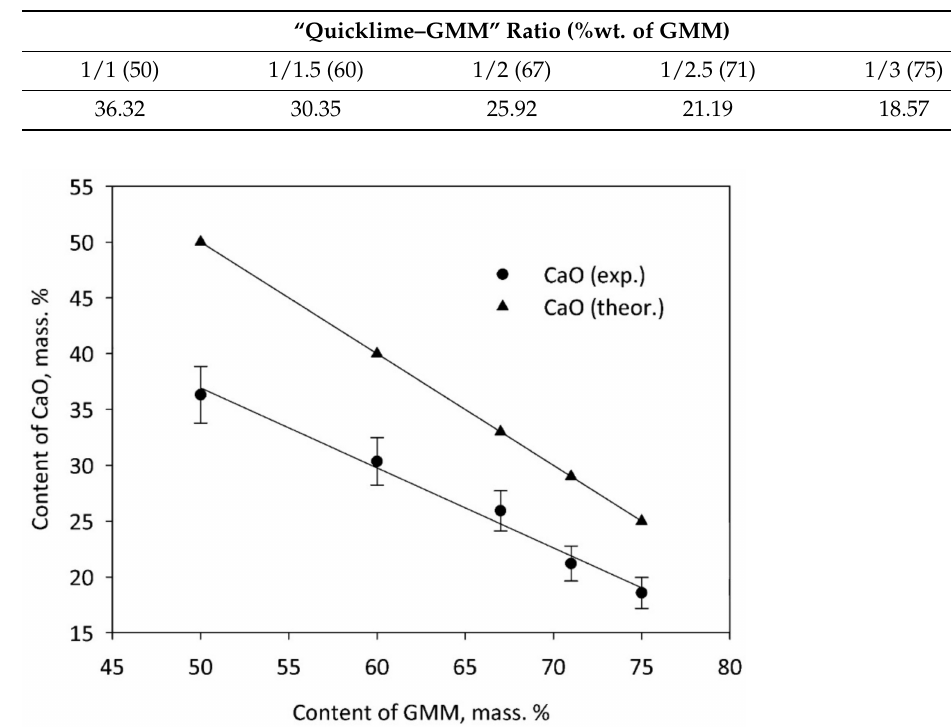
Figure 8. Theoretical and experimental lines of content variations for CaO in the binding